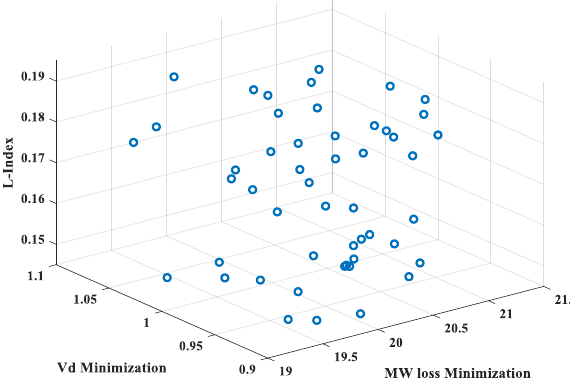
Figure 7. Pareto optimal front for the IEEE 57 test system.